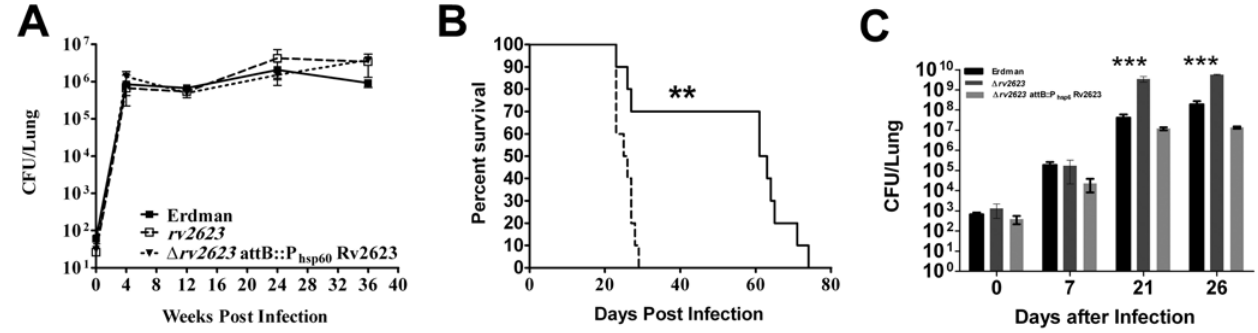
Figure 4. InVivo growth of D rv2623 in mice. (A) C57BL/6 mice infected with various strains of M. tuberculosis via the aerosol route with a low dose ( , 100 CFU) were assessed for lung bacteria burden. Wild type Erdman (closed box, solid line); D rv2623 (open box, dashed line) and the complemented strain D rv2623 P hsp60 ::Rv2623 (triangle, dashed line). (B) Survival curve of C3H/HeJ mice infected via aerosol with 750–1000 CFU. Erdman and D rv2623 -infected mice are represented by solid and dashed lines, respectively. (C) Kinetics of infection, established via aerolization (inoculum: , 1,000 CFU) of wildtype Erdman (dark), D rv2623 (dark grey), and the complemented strain D rv2623 P hsp60 ::Rv2623 (light grey), as assessed by lung bacterial burden. **p , 0.01; ***p , 0.001.